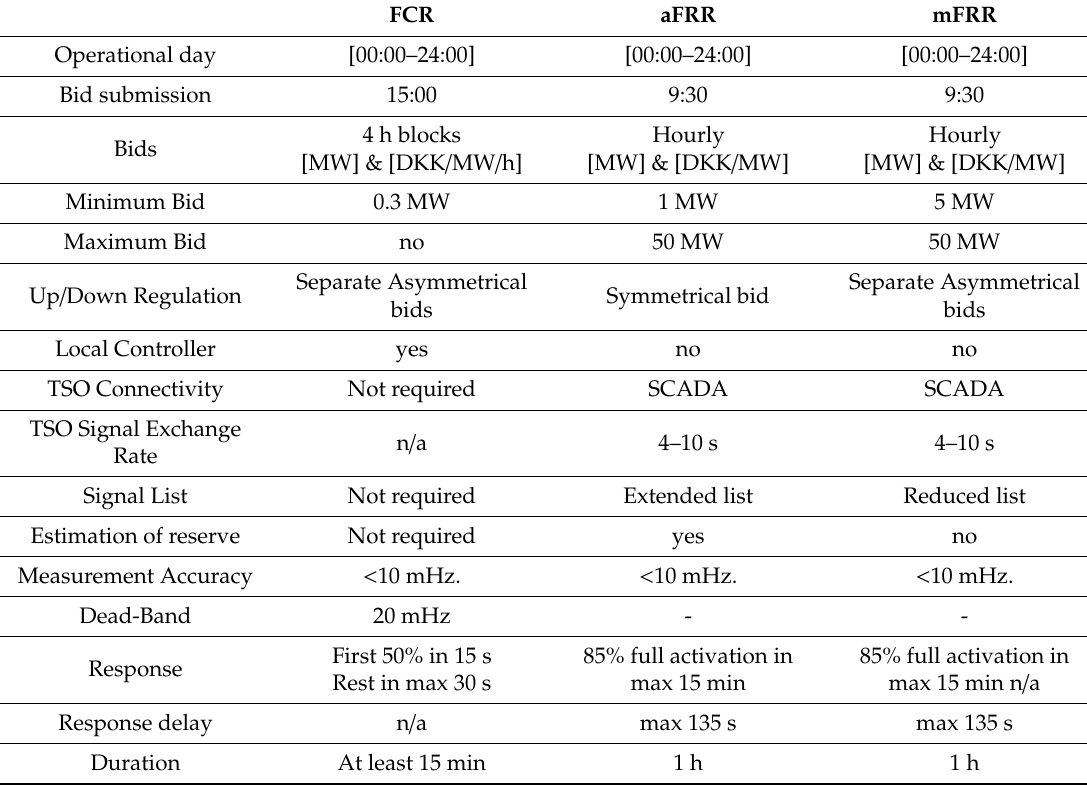
Table 1. Summary of technical requirements for ancillary services in DK1 based on